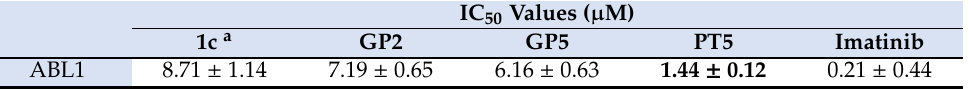
Table 3. The Abelson (ABL) 1 tyrosine kinase inhibition of selected compounds and